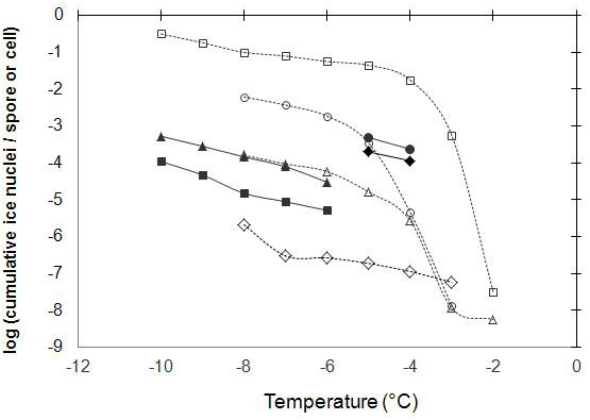
Fig. 1. Cumulative ice nucleation activity of urediospores of rusts (solid lines) compared to that of cells of Pseudomonas syringae (dashed lines). Examples are presented to represent the range of ac- tivities observed among the rust samples from this study and among strains of P. syringae from our collection and reported in the liter- ature (Cit7 as reported in Fig. 4 of Orser and colleagues, Orser et al., 1985). Rusts whose activity is illustrated here were collected from Dactylus Orchard grass ( (cid:4) ) ( Puccina sp.), greenhouse-grown wheat ( N ) ( P. triticina ), field wheat ( (cid:7) ) ( P. graminis f. sp. tritici ) and wild oats ( • ) ( Puccinia sp.). Strains of P. syringae that illustrate the range of the activity of this bacterium include Cit7 ( (cid:3) ) from a citrus orchard, CC0229 ( (cid:13) ) and CC0094 ( 4 ) from epidemics of cantaloupe blight, and CC0670 from a wild plant of the Primula species ( ♦ ). Curves for cumulative freezing spectra of rusts are not as complete as those for P. syringae because of the lack of sufficient spore quantities to prepare ample volumes for tests across a range of spore